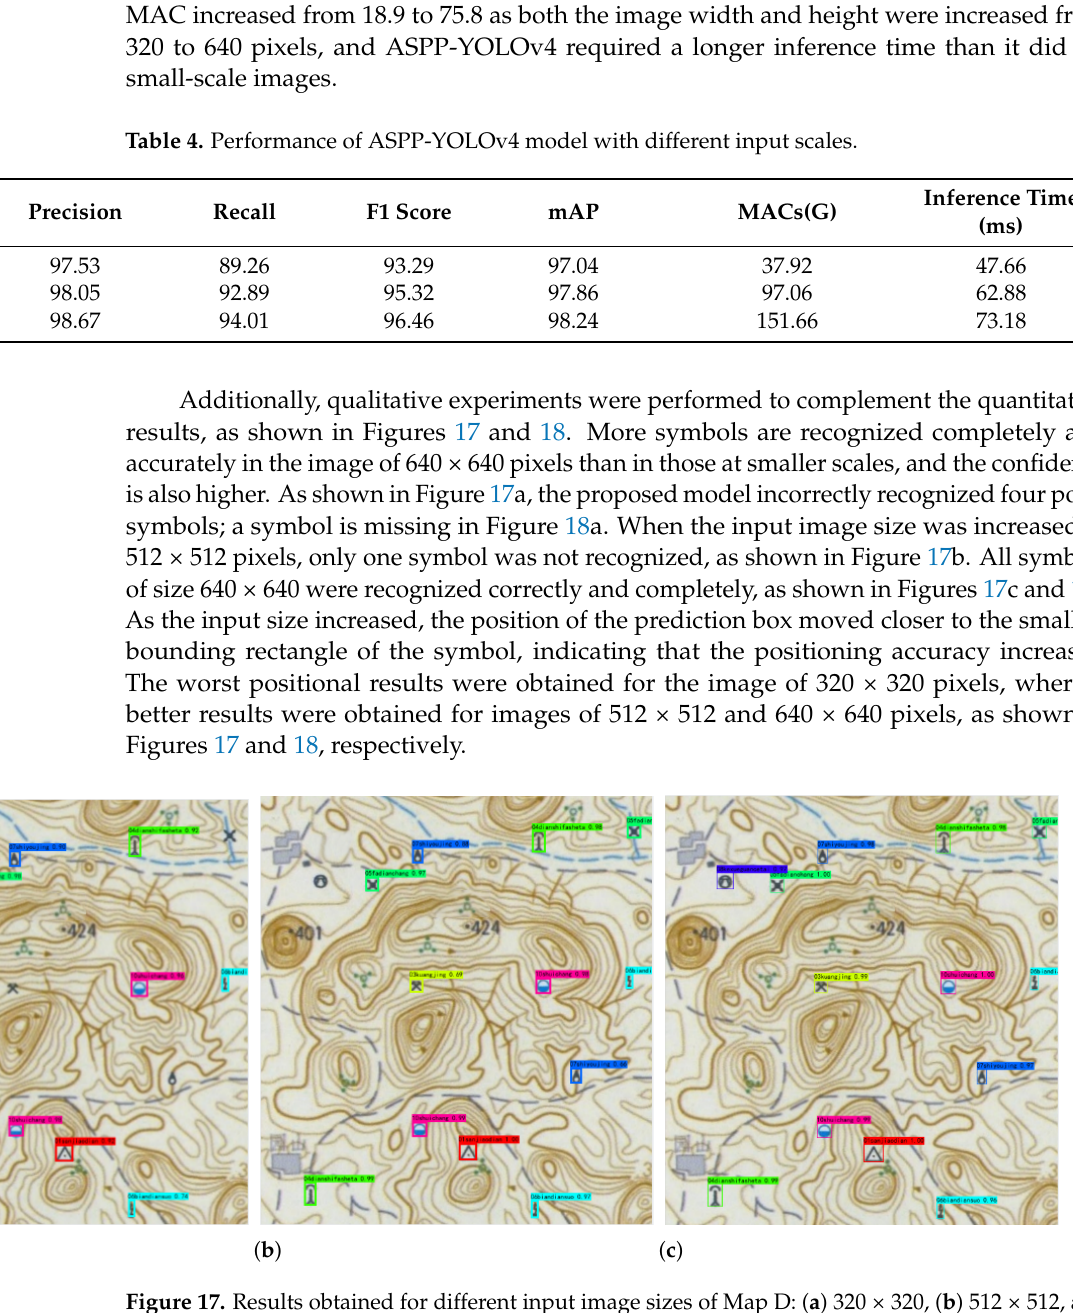
Figure 17. Results obtained for different input image sizes of Map D: ( a ) 320 × 320, ( b ) 512 × 512, and ( c ) 640 × 640